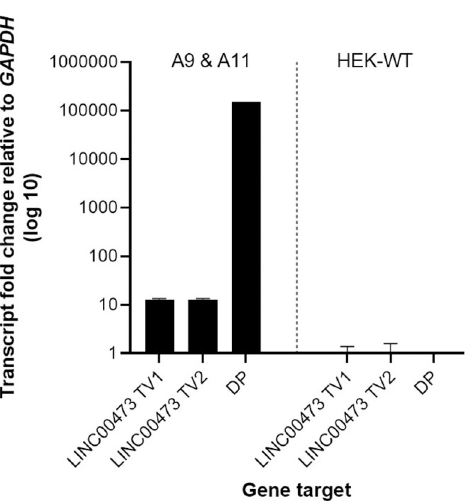
Fig 2. Clones with DP fusion protein share common alterations with FLC tumors. Hierarchical clustering of A9, A11 clones at 2 fold transcript change compared to HEK-WT with the most upregulated genes in (a and c) and most downregulated genes in (b). (d) Scatterplot heat map identifies CGA , LINC00473 , PDE10A , MN1 , and FZD10 as common upregulated genes in A9 and A11 and a cohort of FLC tumor samples.